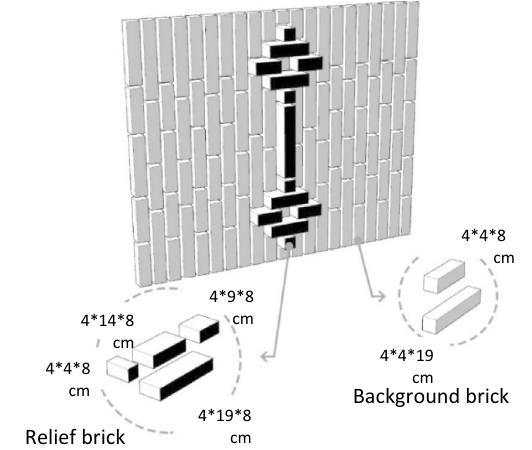
Fig. 3 Xowun decoration in a pattern-like